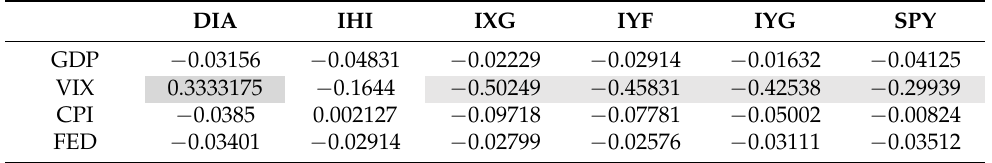
Table 7. Correlation between ETF returns and macroeconomic time series. Significant correlations (5% significant level) are highlighted in gray. Period: January 2014–May 2020. DIA IHI IXG IYF IYG SPY GDP − 0.1644